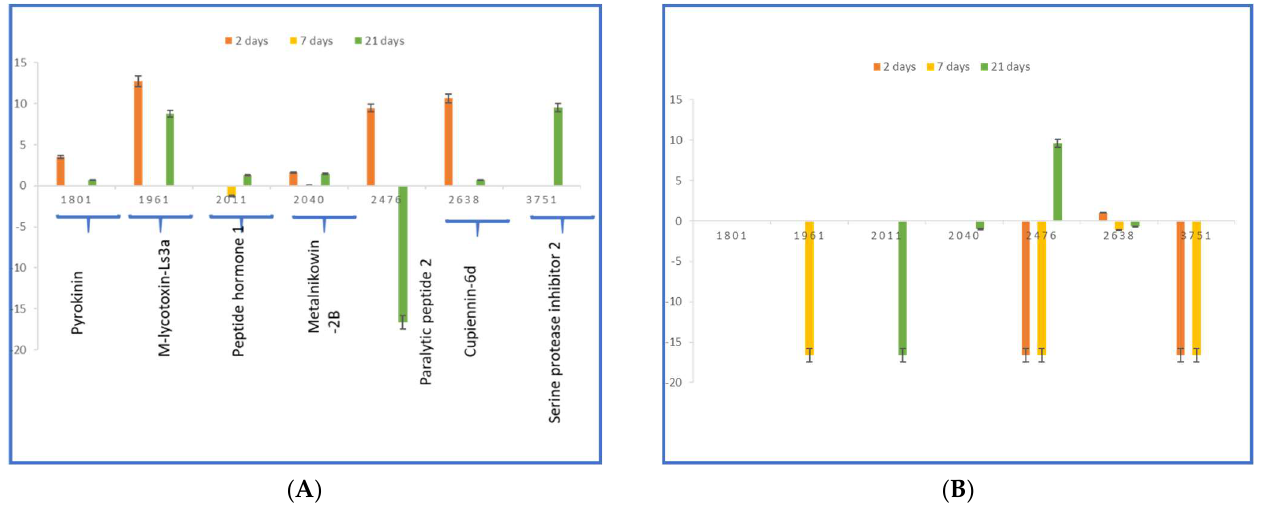
Figure 6. The ratio for the intensity after 2, 7, and 21 days of PND exposure relative to the control is depicted on the y -axis as a log2 ratio to clearly see up/downregulation of peptides relative to the x -axis. Panel ( A , B ) show up/downregulation of peptides for female and male groups, respectively. The error bars denote the standard error of the mean ( n = 3).